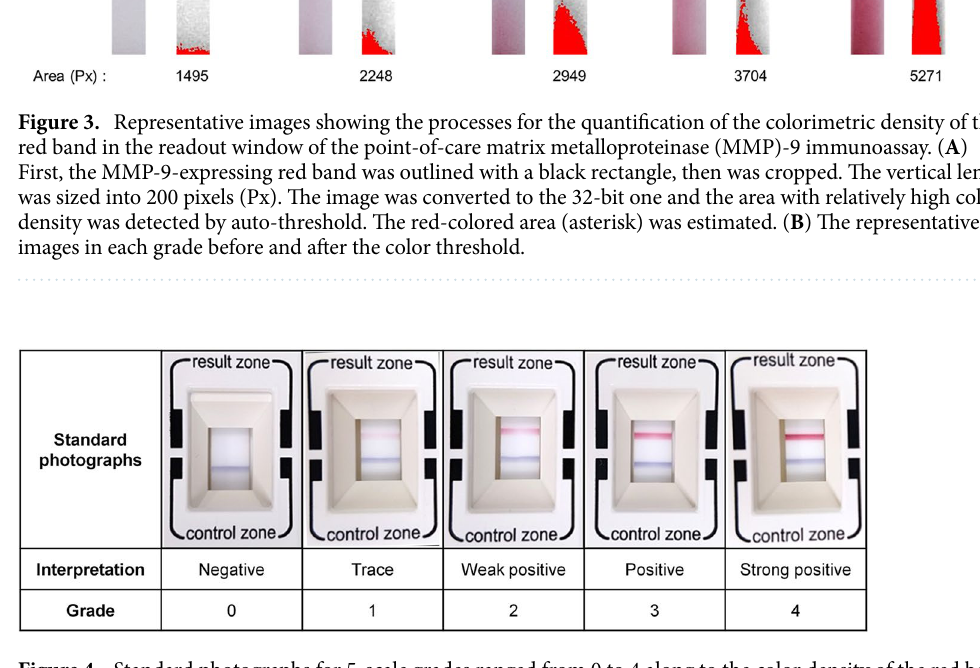
according to the severity of tear MMP-9 expression, the relationship between the variance of readout grades according to the 5-scale grading system and the values of quantified colorimetric densities was analyzed using the linear regression analysis.